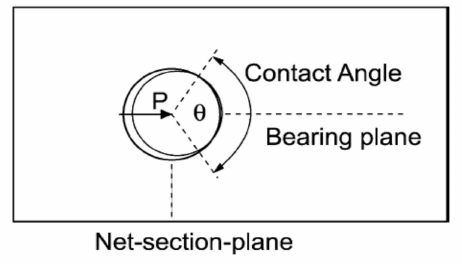
Figure 3. Contact angle for bolt-hole bearing